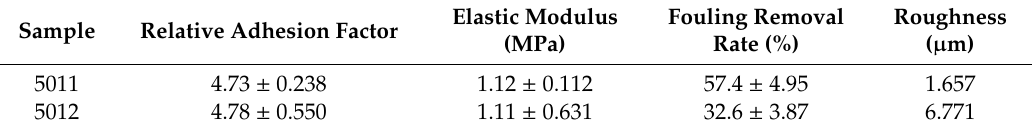
Table 7. Influence of elastic modulus and surface roughness on the amount of fouling removal